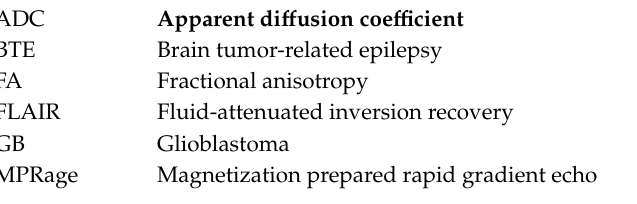
Figure S1: Box plots for FA first order features in tumors in epilepsy location / di ff erent location, Table S1: First order